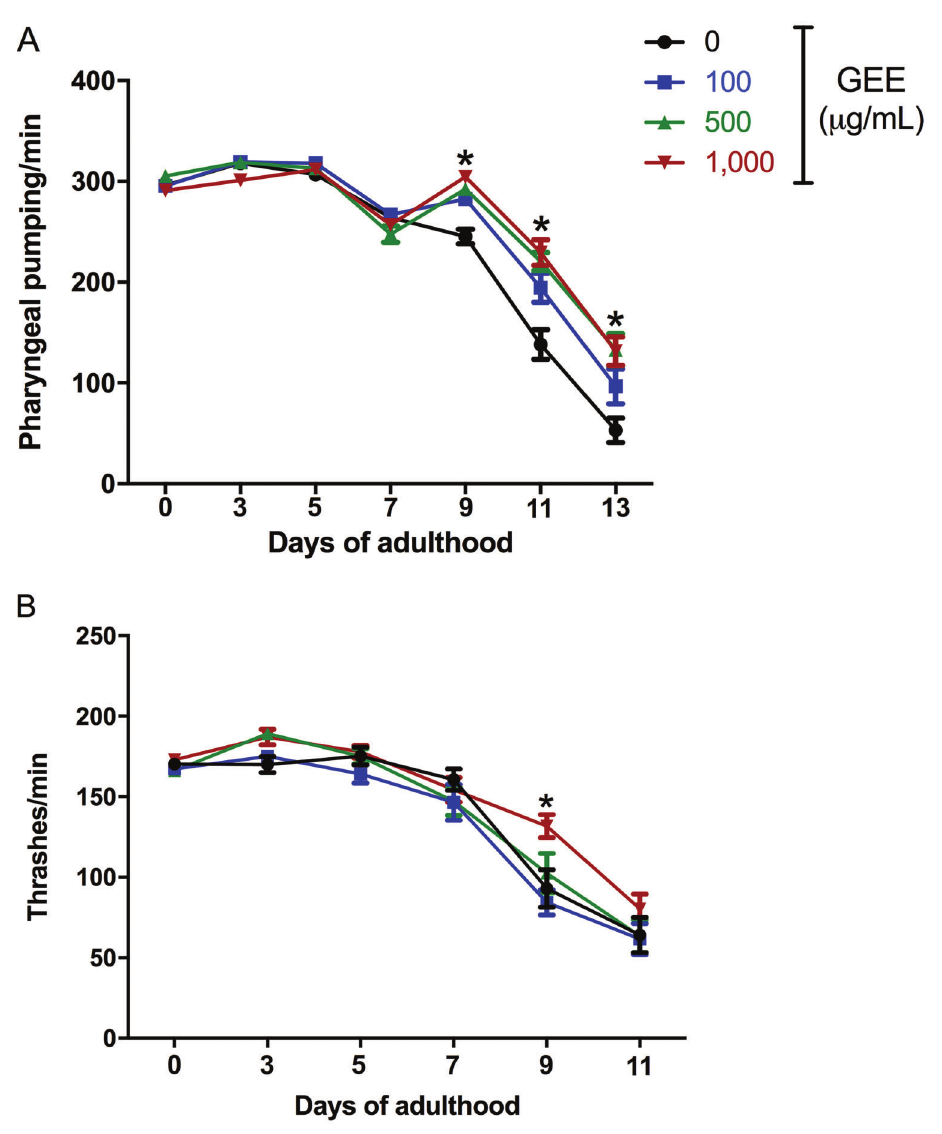
Figure 1. Guarana ethanolic extract (GEE) effects on behavioral parameters related to health span. Pharyngeal pumping rate ( A ) and thrash frequency ( B ) during aging in wild-type worms. Data are reported as mean ± SD (n=30 worms per group). *P o 0.05 compared to control (one-way ANOVA followed by Bonferroni multiple comparison